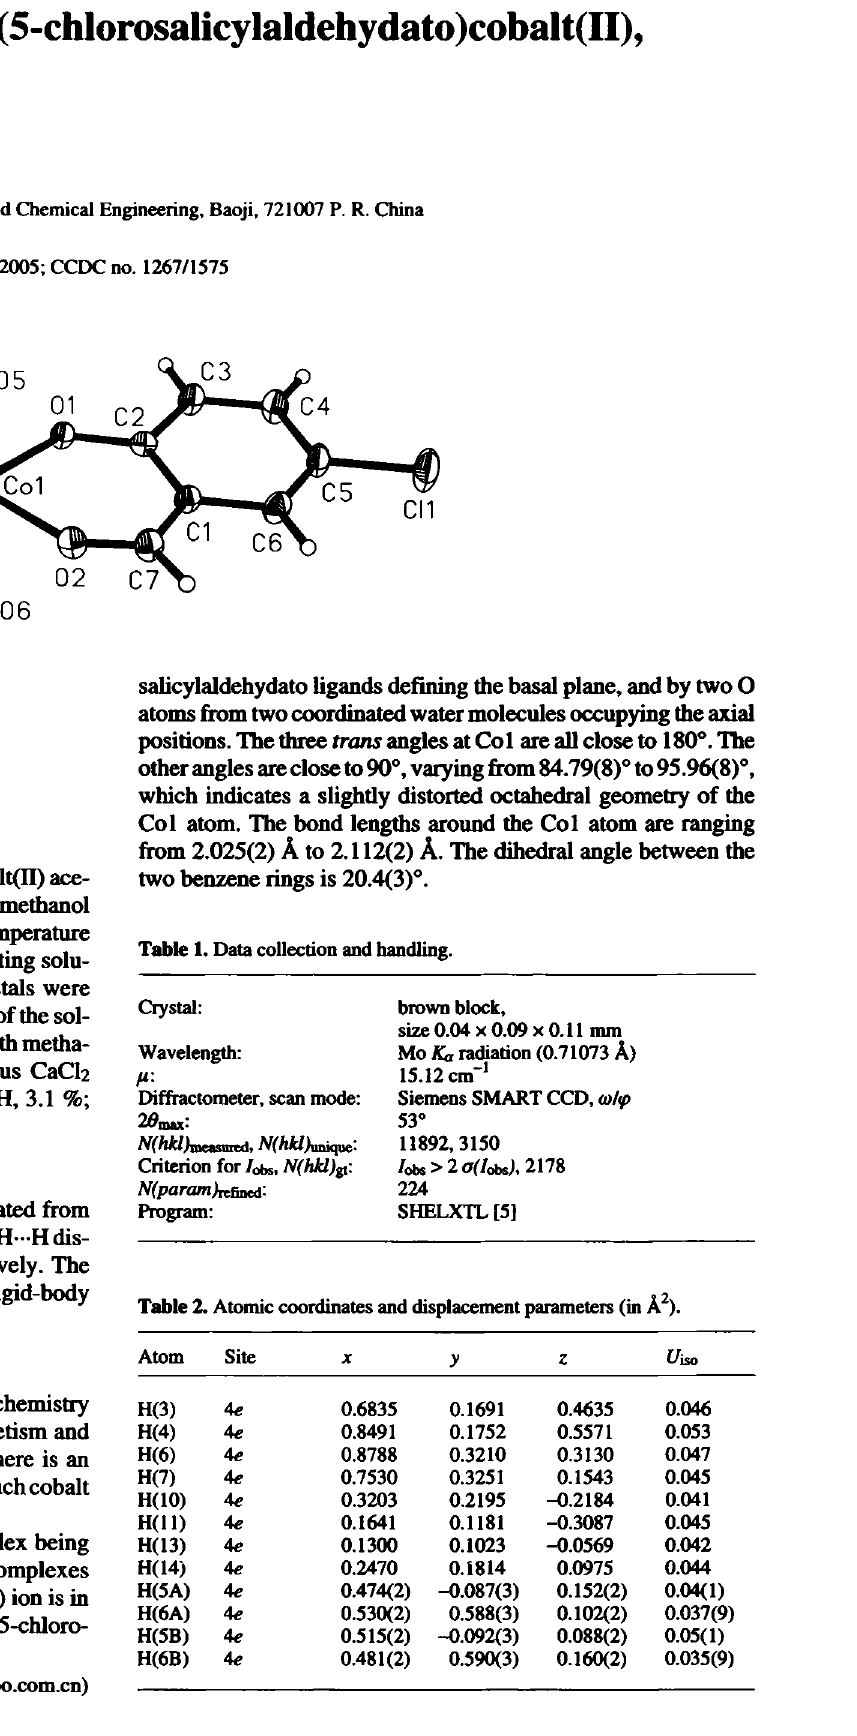
Table 1. Data collection and handling.